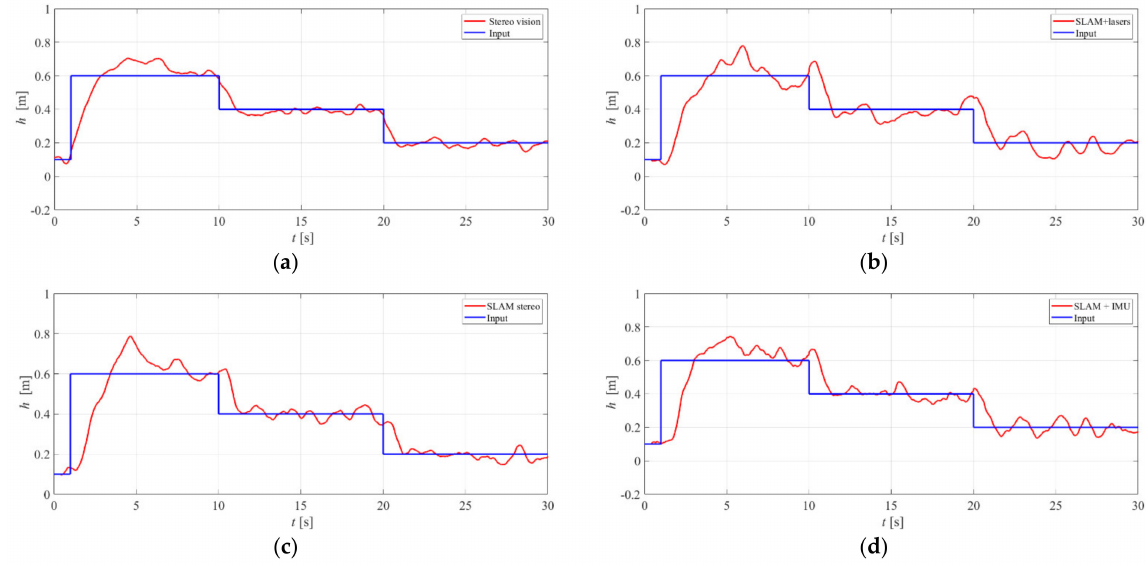
Figure 19. Distance-from-the-bottom control at a speed of 0.1 m/s: ( a ) stereo vision; ( b ) SLAM lasers; ( c ) SLAM stereo; ( d ) SLAM IMU.